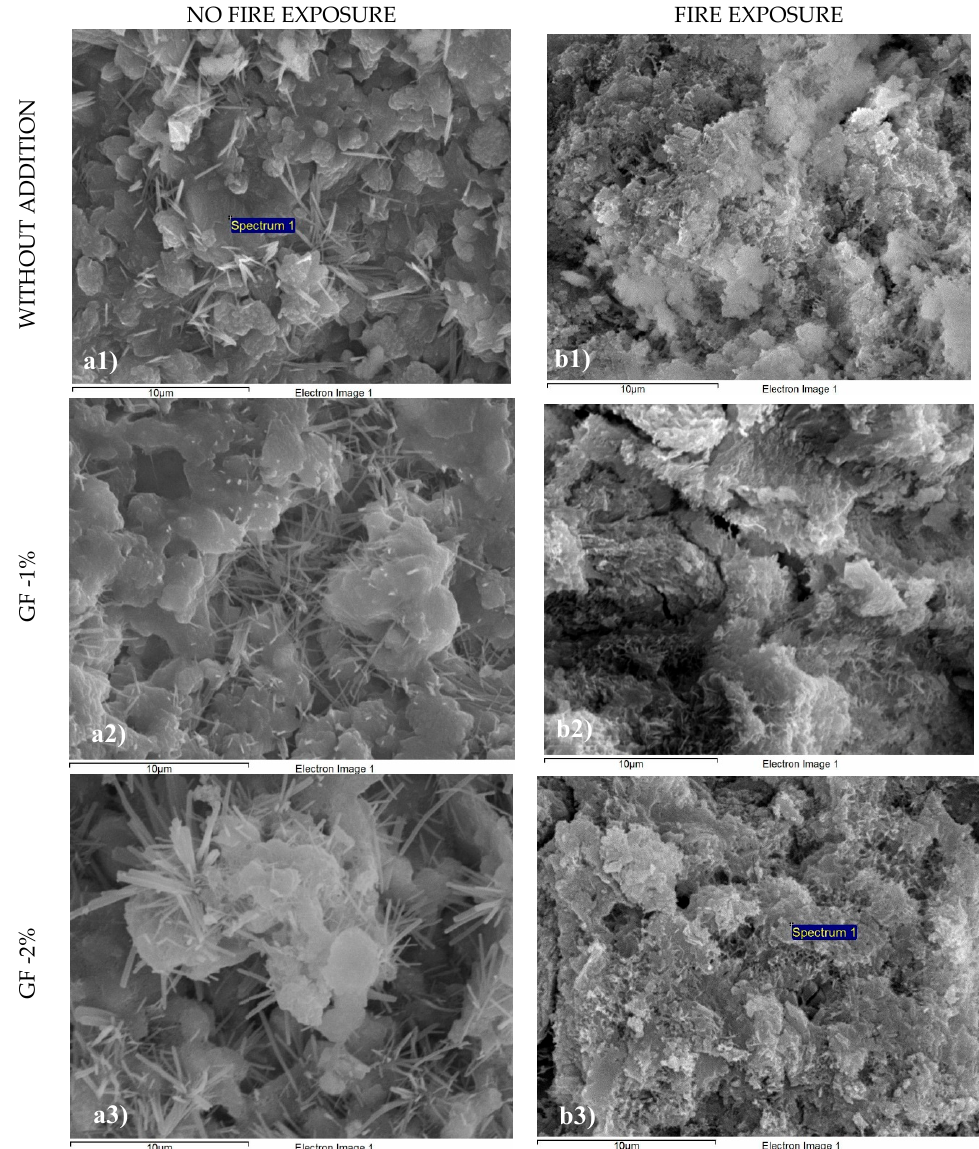
Figure 10. Scanning electron microscopy at 5000 magnifications in test pieces SA, GF-1% and GF-2%. ( a ) Before thermal aggression; ( b ) After thermal aggression.